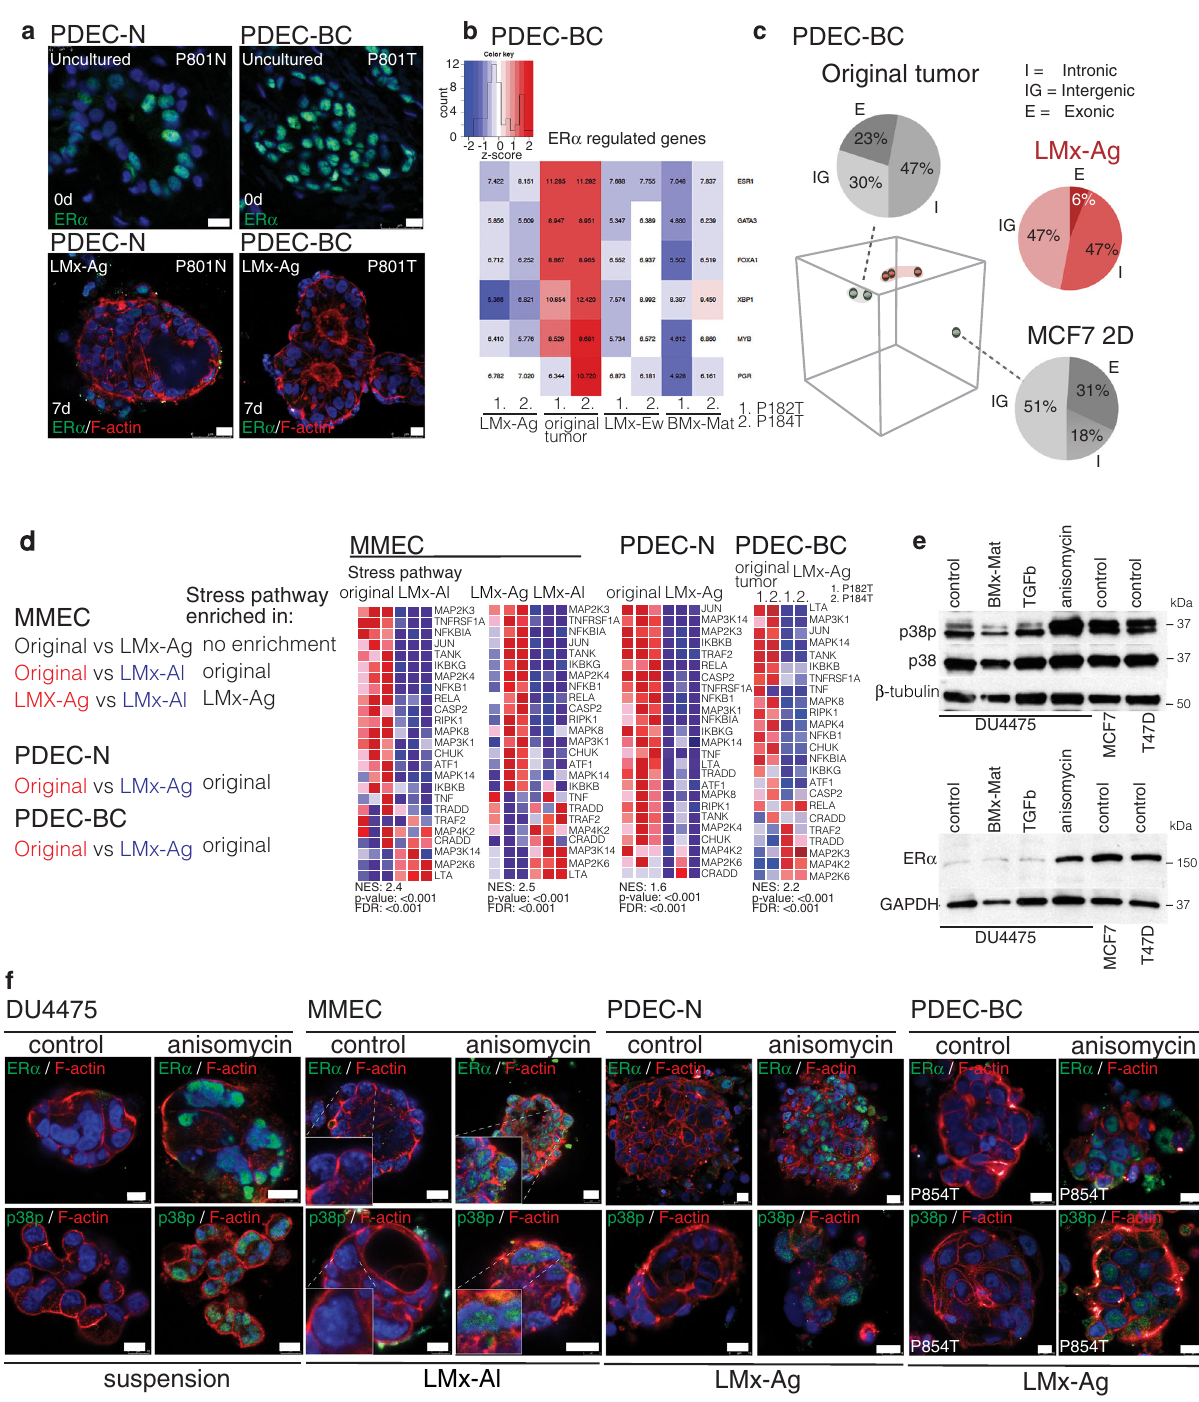
Fig. 5 Stress signaling is required for ER α expression. a Immuno fl uorescence staining of ER α (green) in uncultured PDEC-N and PDEC-BC samples and after 7 days in a LMx-Ag matrix. N = 5 explants examined from 3 biologically independent samples. b The heatmap shows the expression of ER α -regulated gene sets in PDEC-BCs (P182T and P184T) in different matrices in comparison to the uncultured original samples. c PCA of RNAseq data obtained from PDEC-BC and MCF7 cells cultured in LMx-Ag matrix (red) for 7 days compared to the uncultured original tumor / 2D cultured MCF7 cells (grey). Pie charts show the relative distribution of exonic (E), intronic (I) and intergenic (IGR) transcripts in the RNA sequencing. d Heatmaps from GSEA analysis show the enrichment of stress pathway in MMECs, PDEC-N and PDEC-BCs. Different comparisons and the corresponding enrichments are shown in left. e Western blot analysis shows the effect from anisomycin treatment on p38p/p38 and ER α expression in the DU4475 TNBC cell line. TGF β (2 ng/ml) serves as the negative control, while MCF7 and T47D are positive controls for the ER α ( n = 3). f , Immuno fl uorescence staining of p38p in DU4475 cells, MMECs, PDEC-Ns, and PDEC-BCs in control and after anisomycin treatment. N = 6 explants examined from three biologically independent samples. Scale bar = 10 μ